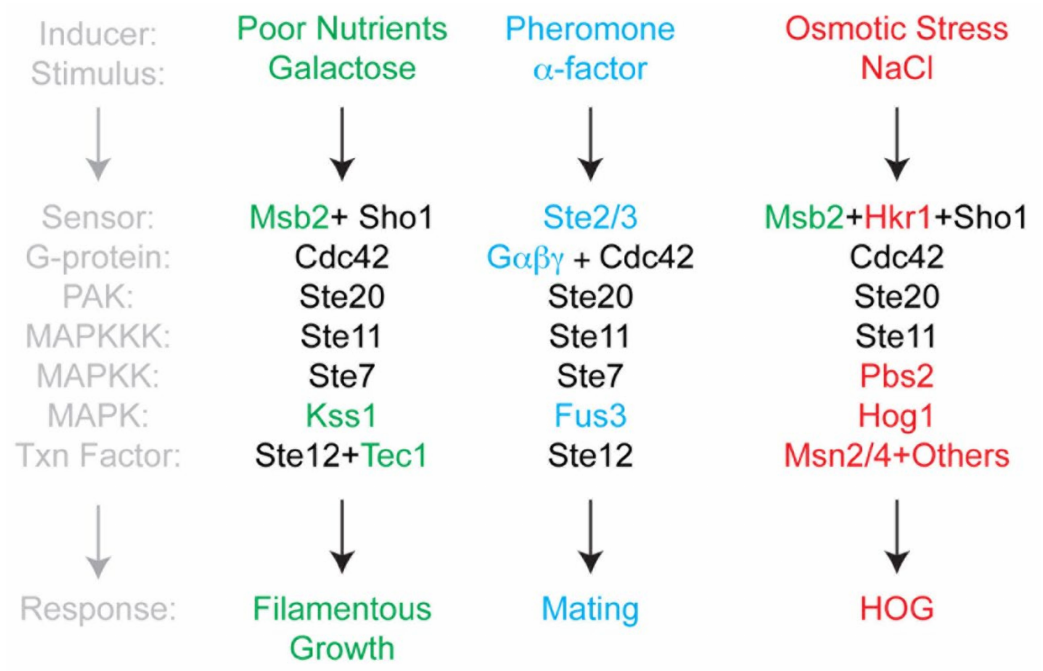
Figure 1. Cdc42-dependent MAPK pathways in yeast. Three yeast MAPK pathways share components, yet induce different responses to different stimuli. Pathway components common to multiple pathways are shown in black. Pathway-specific proteins are colored (red letters: hyperosmolarity glycerol response (HOG) pathway; blue letters: pheromone response; green letters: filamentous growth). Not all components are